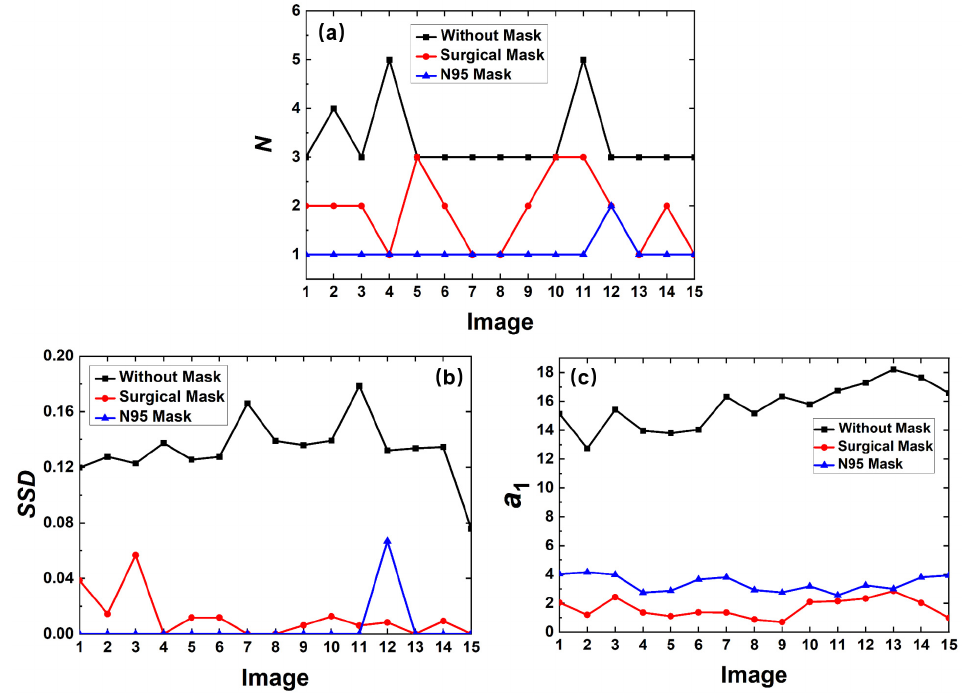
Figure 10. Feature values to identify whether to wear mask captured from 15 images: ( a ) the N value, ( b ) the SSD value, and ( c ) the a 1 value of three types of curves.